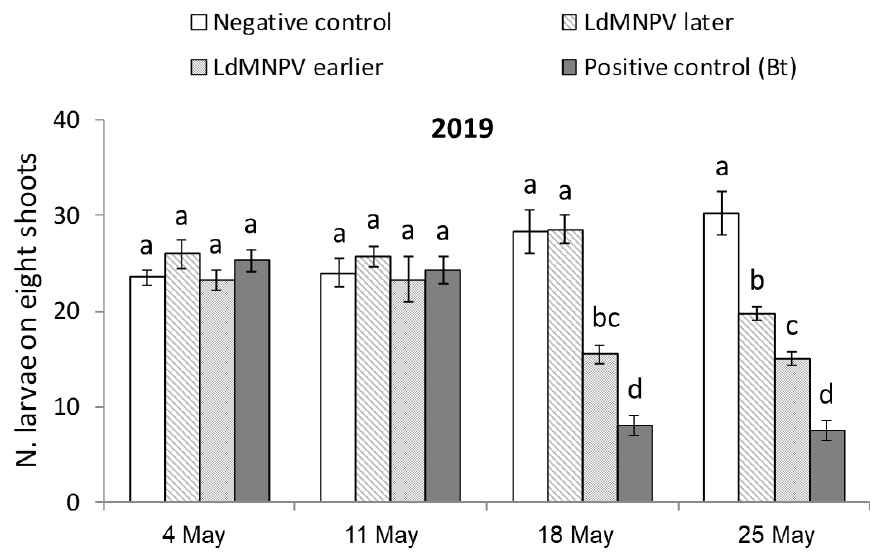
Figure 3. Larval density (mean ± SE) assessed by sampling 8 shoots/plot in the time–response trial with LdMNPV applications from the ground in 2019. Different letters (a, b, c, d) above bars indicate significant differences among means within each sampling date (ANOVA Mixed Proc., LSMEANS, p <